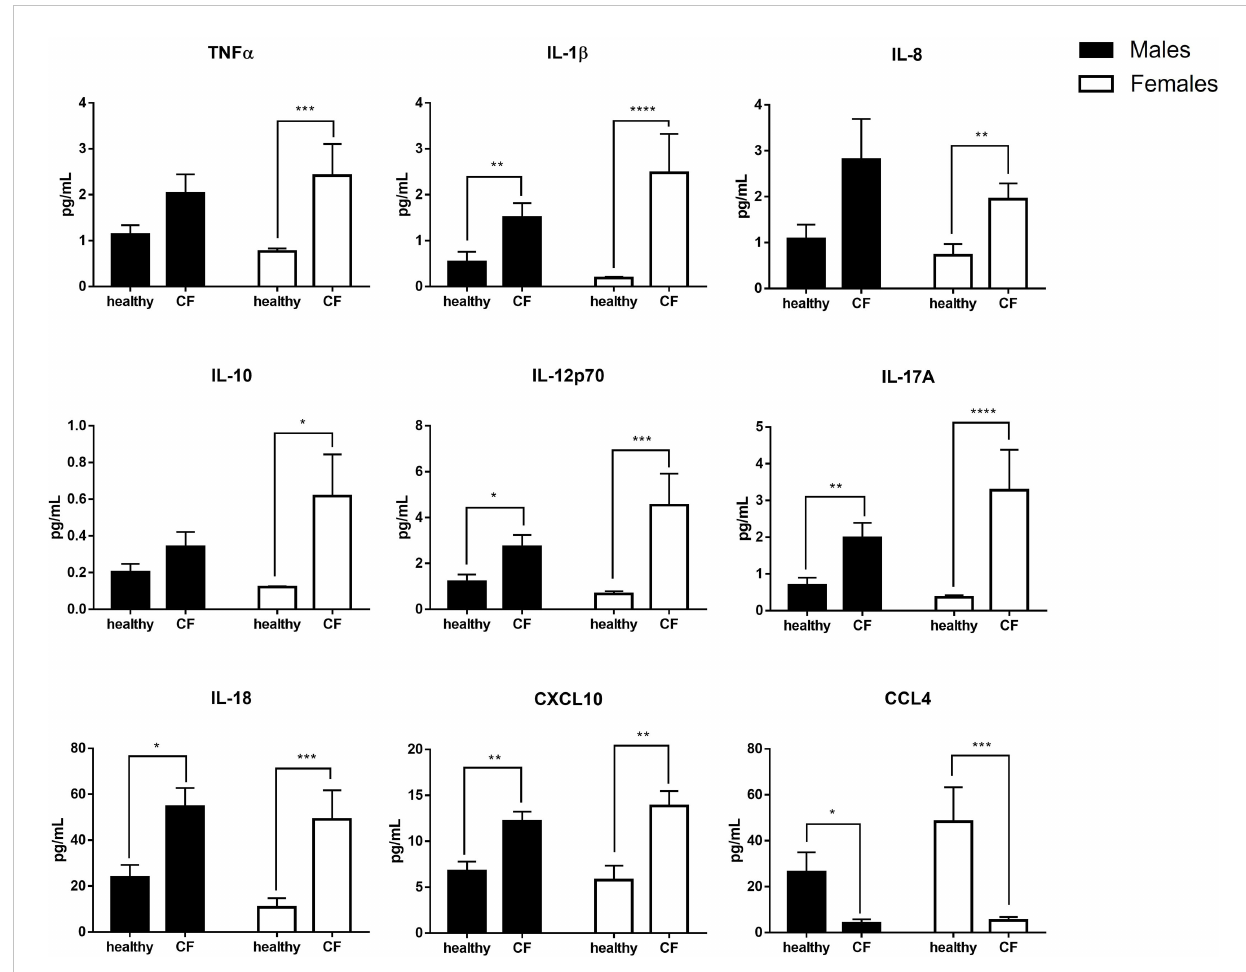
FIGURE 1 Sex-based analysis of the production of pro- and anti-in fl ammatory mediators in the plasma of CF patients (n=29; 15 males and 14 females) and healthy controls (n=20; 10males and 10 females). Graphs show the mean ± SEM. *p<0,05; **p<0,01; ***p<0,001: ****p<0,0001 (Mann Whitney U